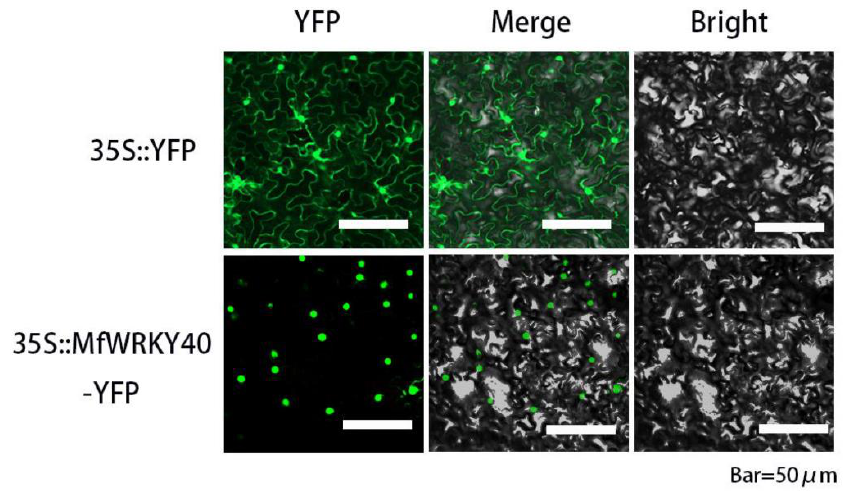
Figure 2. Subcellular localization of MfWRKY40. YFP, yellow fluorescent protein.